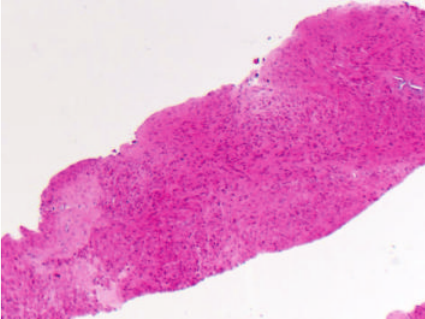
Figure 5: Immunohistochemical study: desmin, focally positive ( × 40 magnification).